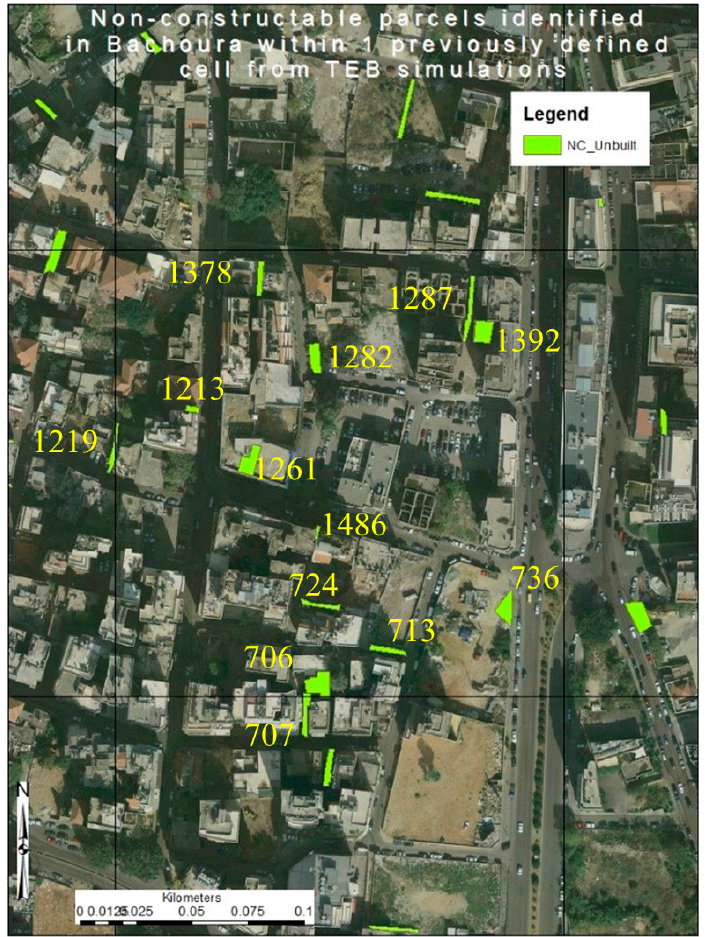
Figure 2. Non-constructible parcels identified in previous TEB cell(s) in Bachoura District. Table 1. Characteristics of existing NCs with proposed types of cool materials or reflective coatings and their thermal properties in Bachoura District. Plot